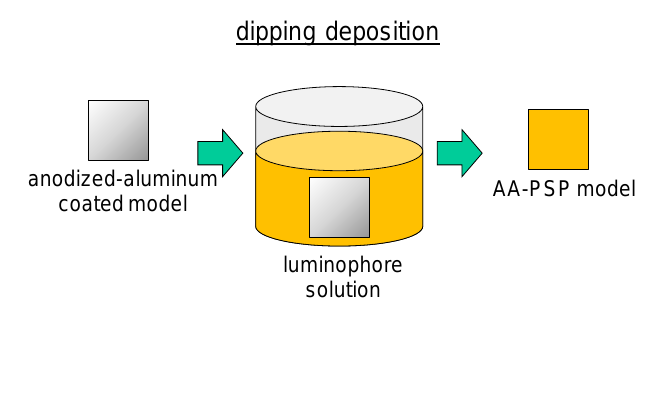
Figure 3. Schematic description of dipping deposition method.